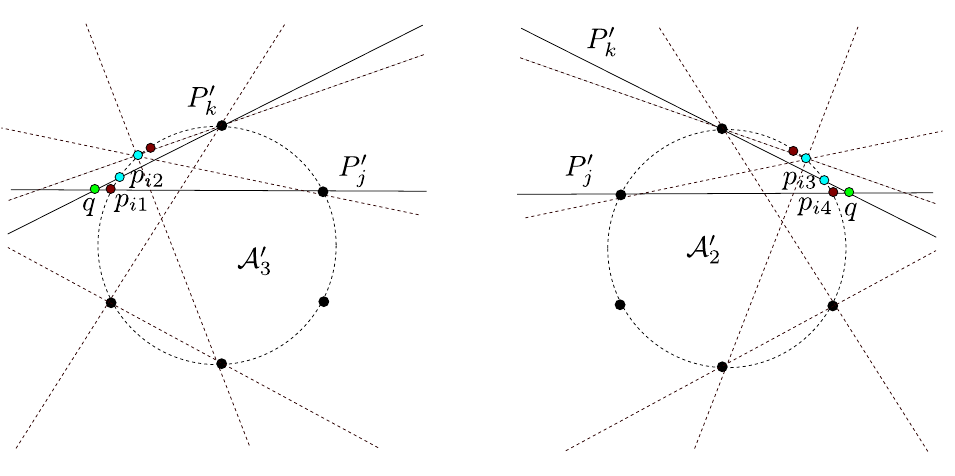
Fig. 5: Schematic depiction of conditions (2) and